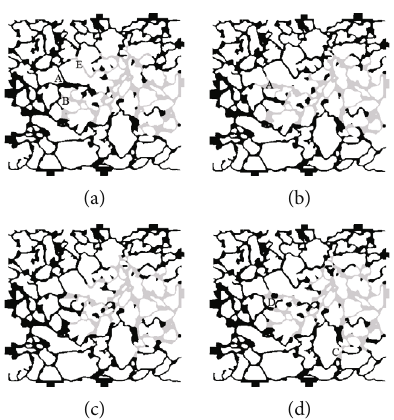
Figure 3: Final oil-water distribution at di ff erent water injection rates under water-wet conditions: (a) 0.10m · s -1 ; (b) 0.15m · s -1 ; (c) 0.20m · s - 1 ; (d) 0.25m · s -1 .